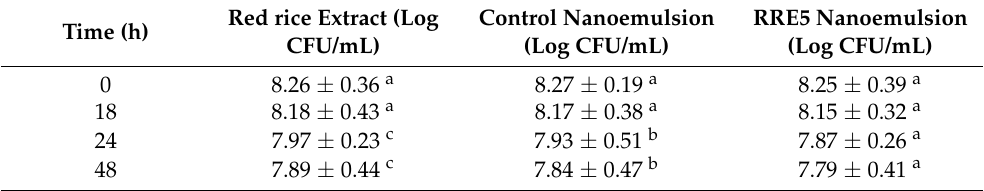
Table 2. Time-kill study of red rice extract and RRE5 nanoemulsion against Staphylococcus aureus . Red rice Extract (Log Time (h) CFU/mL) (Log